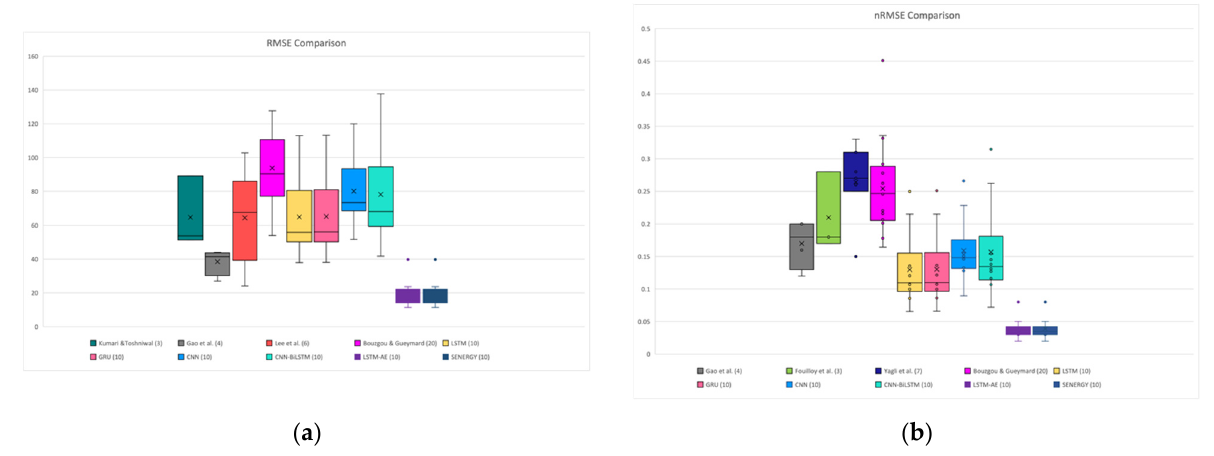
Figure 45. Comparison of multiple works based on: ( a ) RMSE; ( b ) nRMSE. In Figure 46a, the MAPE results of Lee et al. [27], and Bouzgou and Gueymard [30] are compared to the five forecasting models and SENERGY results in this work. SENERGY achieves the lowest error with the smallest variation between ten locations, whereas the CNN model is the worst. In Figure 46b, the comparison is based on the nMAPE results and the same observation about the best and worst performance is true. The work of Lee et al. [27] is eliminated in (b), since GHI mean is not reported and thus nMAPE cannot be calculated. From (a) and (b), we can see the normalization effect on the work of Bouzgou and Gueymard [30]. In (a), it shows better performance than the LSTM, GRU, and CNN- BiLSTM models, whereas in (b) it becomes worse than all of them in value or variation among locations. Unlike the MAE and RMSE results, SENERGY outperforms the LSTM-AE model based on MAPE and nMAPE, because the latter is not the best model for all locations according to these metrics (refer to Figure 25).